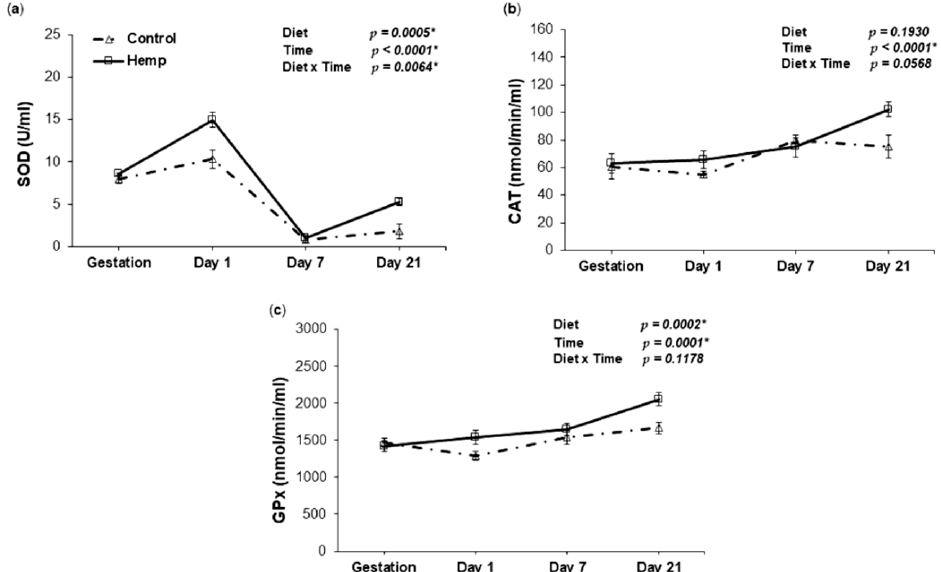
Figure 2. The effect of HD on antioxidant enzyme activities in the plasma of sows throughout the lactation period. ( a ) Relationship between superoxide dismutase (SOD) activity and day of lactation in the plasma of sows fed a control ( Δ symbol) or a hemp seed diet ( □ symbol); ( b ) Relationship between catalase (CAT) activity and day of lactation in the plasma of sows fed a control ( Δ symbol) or a hemp seed diet ( □ symbol); ( c ) Relationship between glutathione peroxidase (GPx) activity and day of lactation in the plasma of sows fed a control ( Δ symbol) or a hemp seed diet ( □ symbol). The p -values for the effects of treatment (diet), time and diet-time interaction are shown. Data are means ± SEM ( n = 5). Asterisk (*) indicates significance ( p < 0.05*).